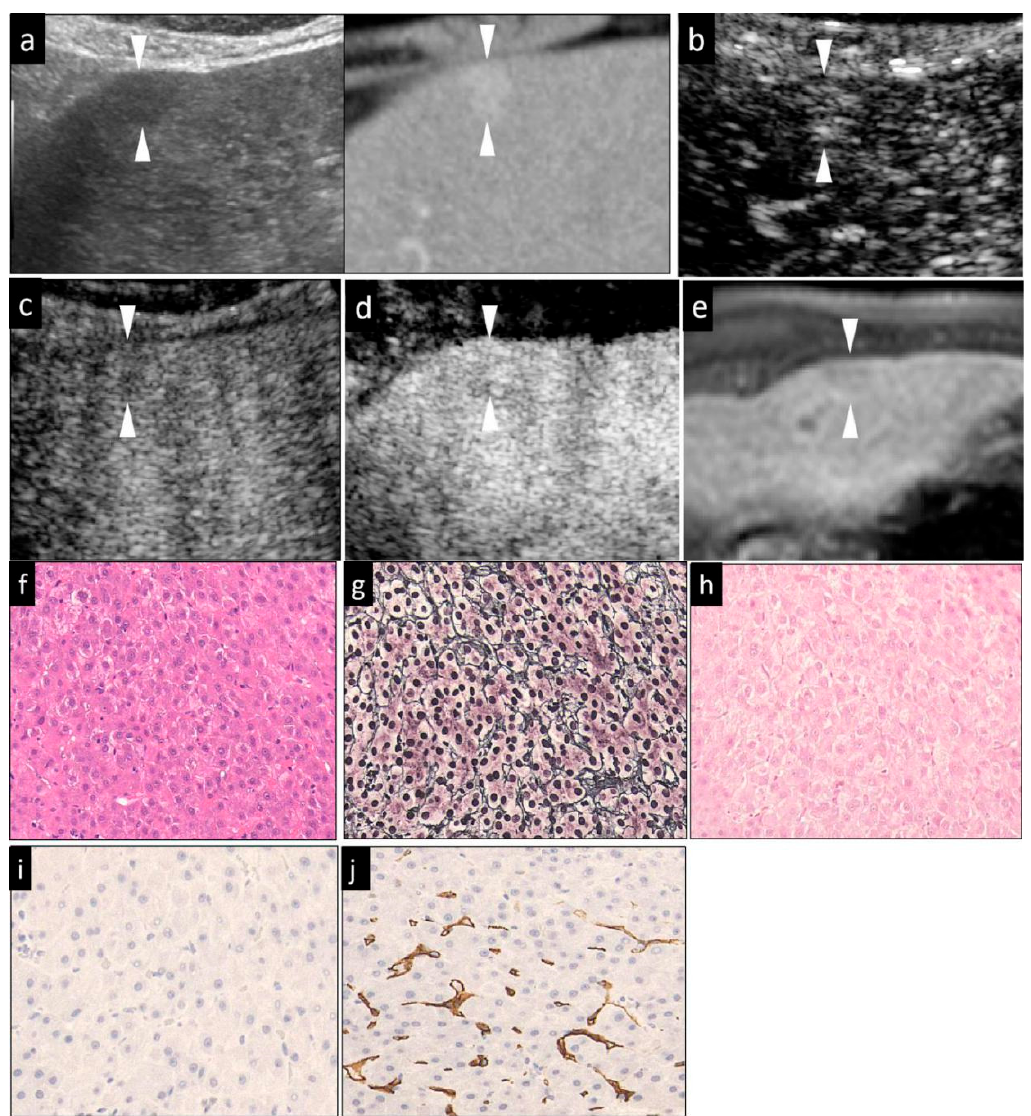
Figure 2. Mild hypervascular well-diff. HCC (maximum diameter, 13 mm) in segment III in a 72-year-old male patient with underlying chronic hepatitis C. ( a ) Fusion imaging combining grayscale US (left side) and the arterial phase of contrast-enhanced CT as reference (right side) on a single screen. The arterial phase contrast-enhanced CT image showed a small high-density area in segment III. The grayscale US image showed a homogeneous hypoechoic area with an unclear margin, and no halo around the lesion. ( b , c ) The arterial-phase Sonazoid CEUS image obtained using low-MI contrast imaging, ( b ) showed hypervascularity. The subsequent portal phase showed isovascularity ( c ). ( d ) After the imaging mode was switched to high-MI contrast imaging, the lesion was seen as an isoechoic lesion in the post-vascular phase. ( e ) The hepatobiliary phase of Gd-EOB-DTPA MRI showed a slight hypointense area in segment III, near the surface of the liver. ( f ) Hematoxylin–eosin (HE) staining showed slight cellular atypia, with an increased nuclear-cytoplasmic ratio and hypercellularity. The tumor cells showed a clear and thin trabecular cord pattern. The trabecular structure is distorted into a layer as thick as two cell layers. ( g ) Silver staining showed that the trabeculae are clearly arranged. ( h ) Victoria blue staining showing a negative stromal invasion (having cancer cells within portal tract)